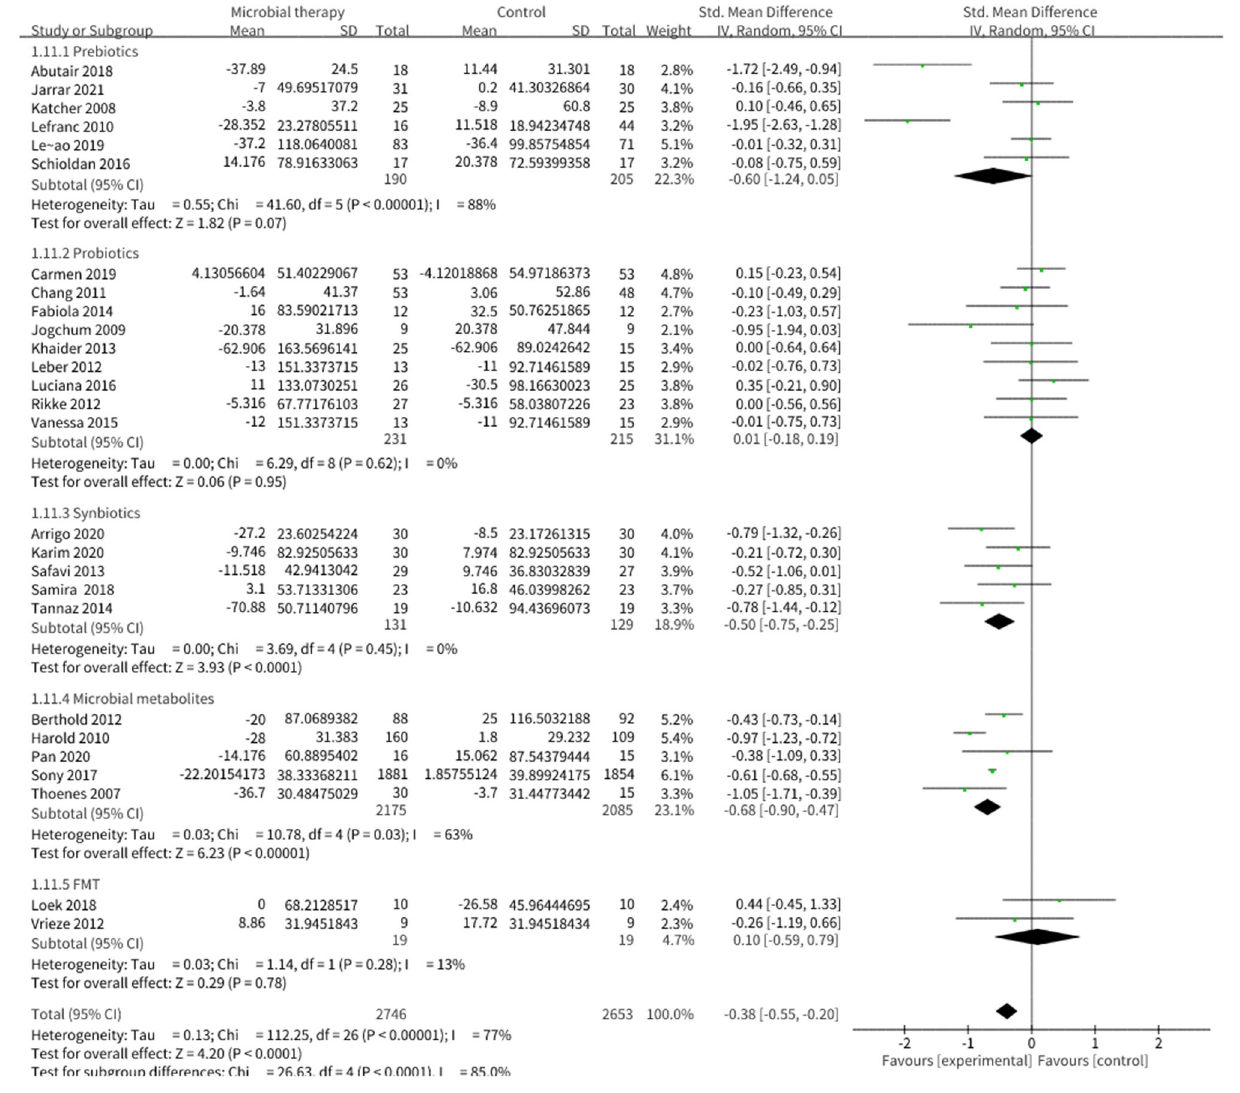
FIGURE 4 | Comparison of SMD of triacylglycerol (TG) control between intervention groups and control groups Tau 2 = 0.13, I 2 = 77%, 95% CI − 0.55 to − 0.20, Z = 4.20, p < 0.0001. Significant difference was shown in